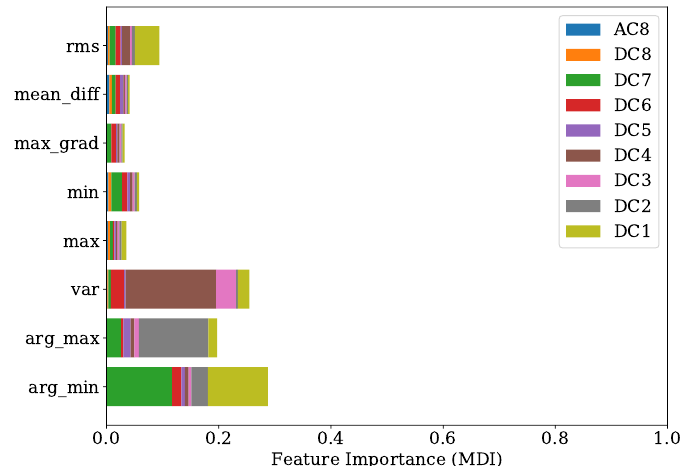
Figure 25. FI of MFB50 regression with regard to training set of engine 2.